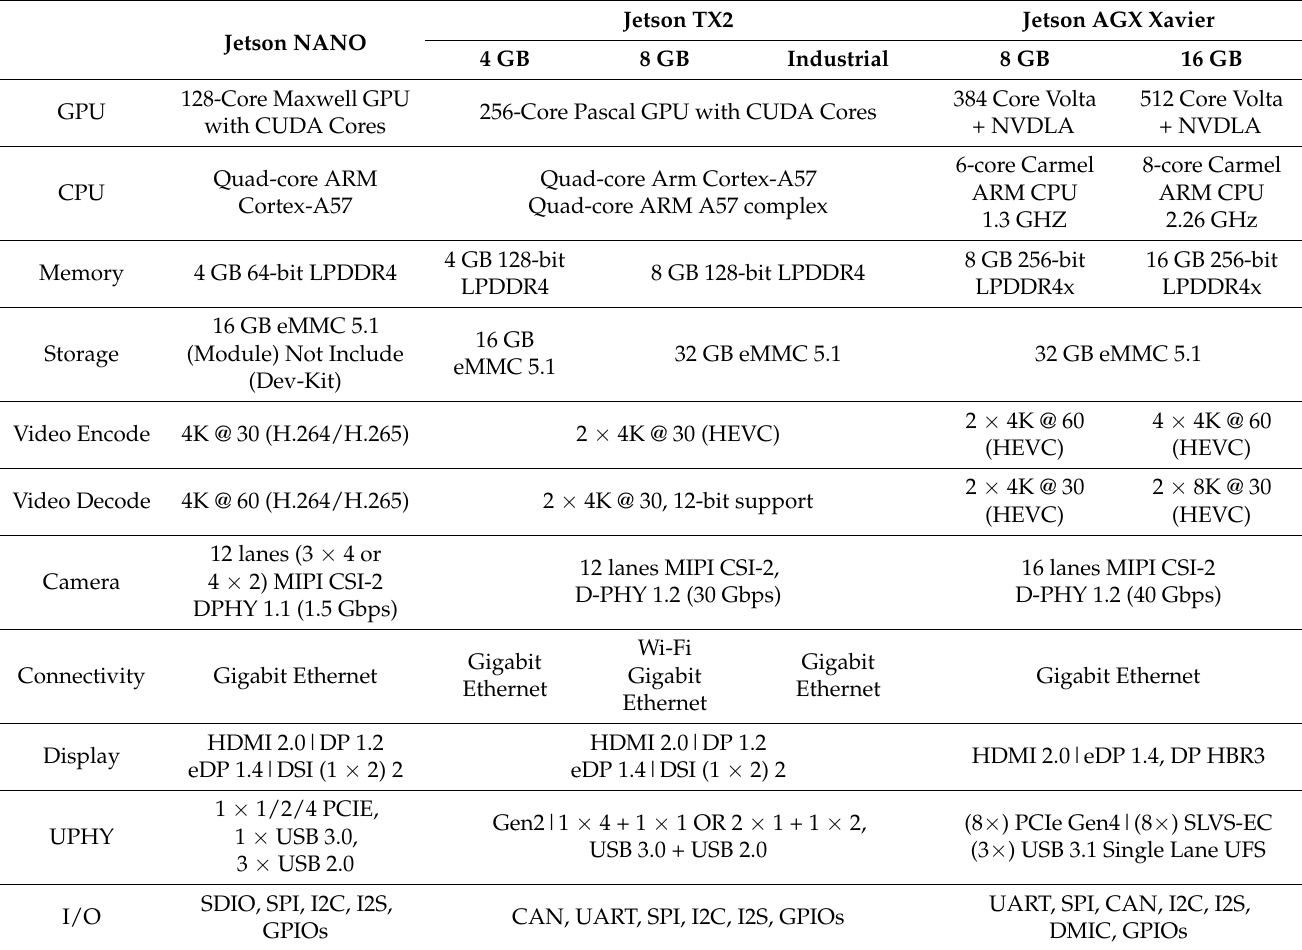
Table 1. A comparative analysis of the Jetson platform provided by